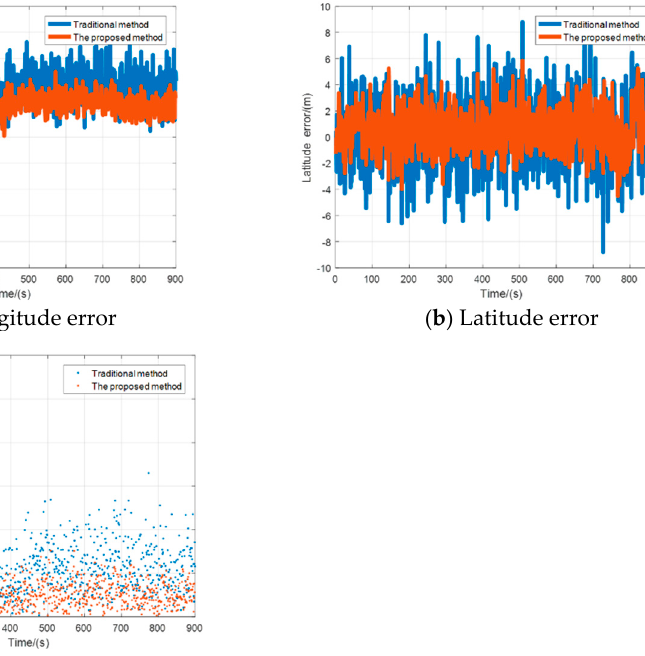
Figure 7. Comparison result of position error in the kinematic test. Table 3. Mean and RMSE of position error under vehicle stationary condition.